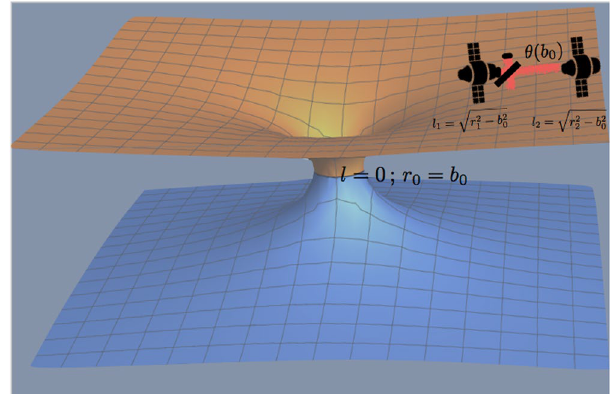
Figure 1. Sketch of the idea. A coherent single-mode state of a laser propagates along a large distance l 2 − l 1 , e.g. between two satellites. If the spacetime is totally flat the distance is just r 2 − r 1 . However, if the spacetime contains a distant wormhole at l = 0 with a throat radius b 0 , the traveled distance will be slightly different even if the spacetime is almost completely flat in that region, namely r 2 , r 1 ≫ b 0 . This small correction of the distance generates a slight phase shift, making the phase θ of the coherent state dependent on b 0 . In principle, b 0 could be estimated by means of homodyne detection. Note that the length scale of the figure is not